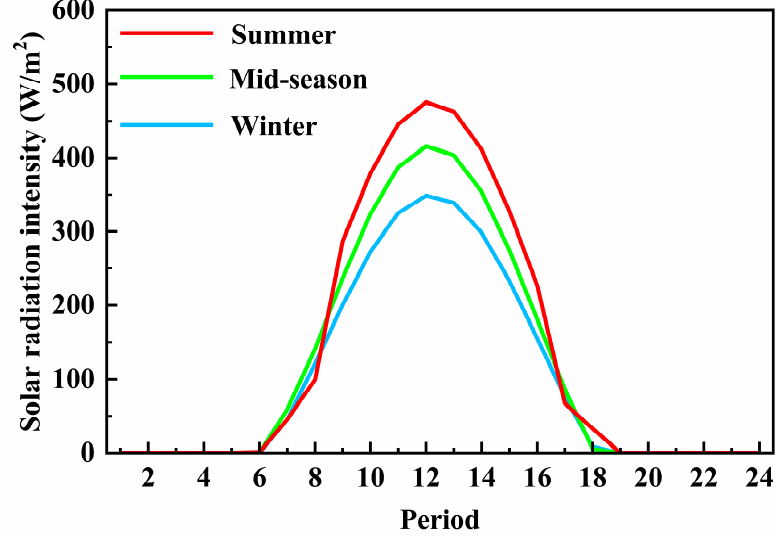
Figure 3. Solar radiation intensity during the three typical